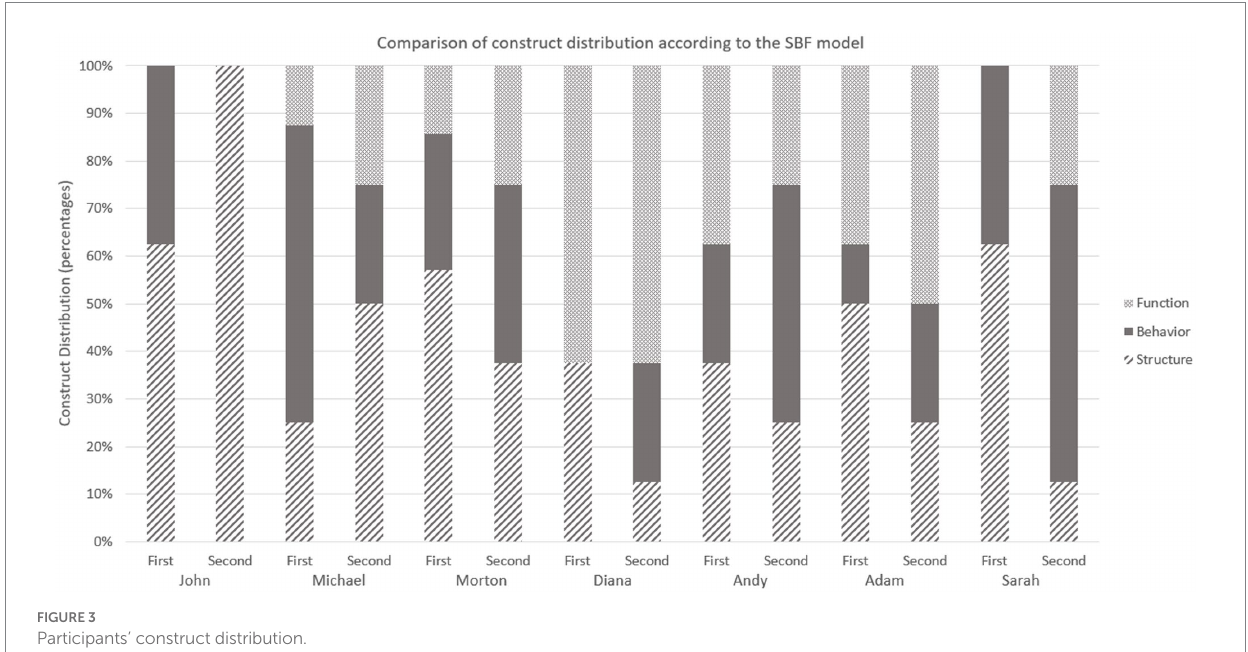
FIGURE 3 Participants’ construct